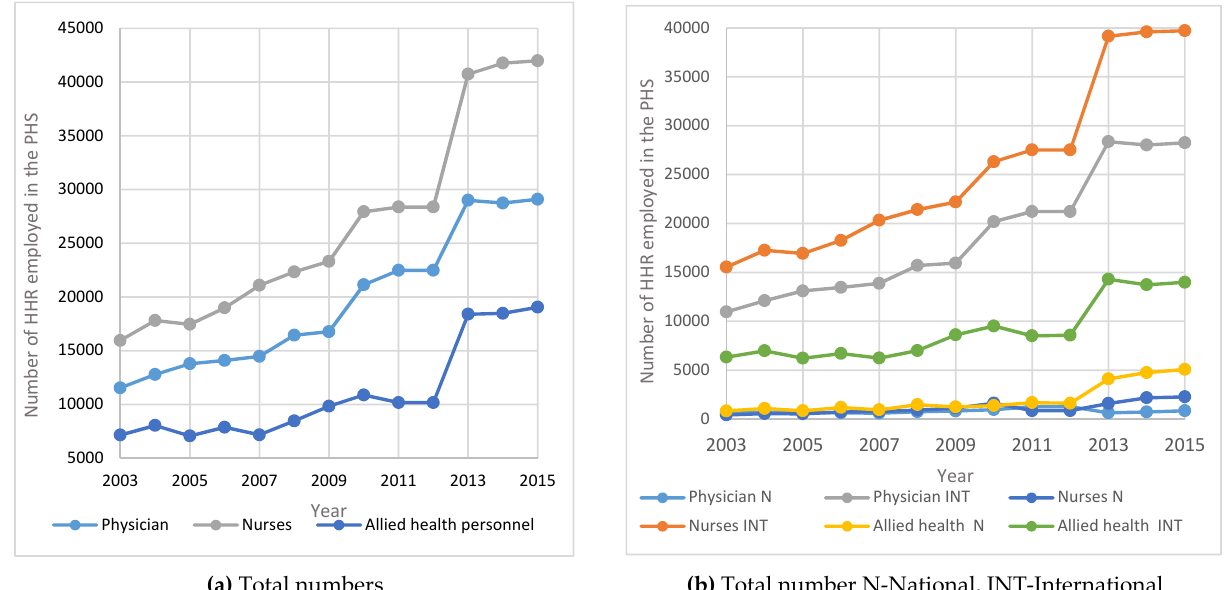
Figure 5. Time Series for HHR in the PHS between 2003 and 2015: ( a ) Total numbers; ( b ) total number N—National;